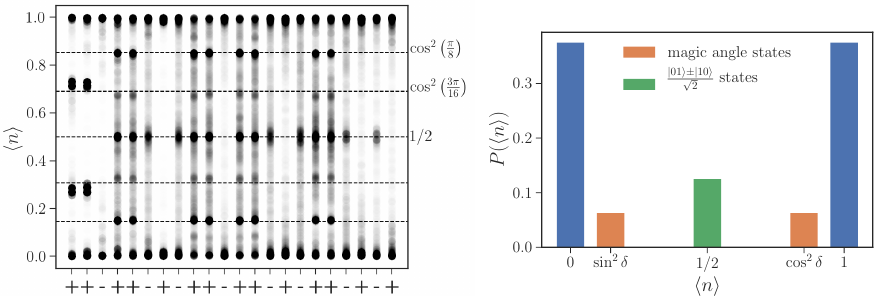
Figure 6: Left: Spatial distribution of the local fermionic density (darker means larger probability), for 5000 eigenstates at the middle of the spectrum, in the MBL phase at h = 5, for one of the 11 Fibonacci configurations of L = 22 sites. The chosen configuration is printed below the horizontal axis ( + : + h potential, − : − h potential). Right: Density distribution for the toy model considered in the text.